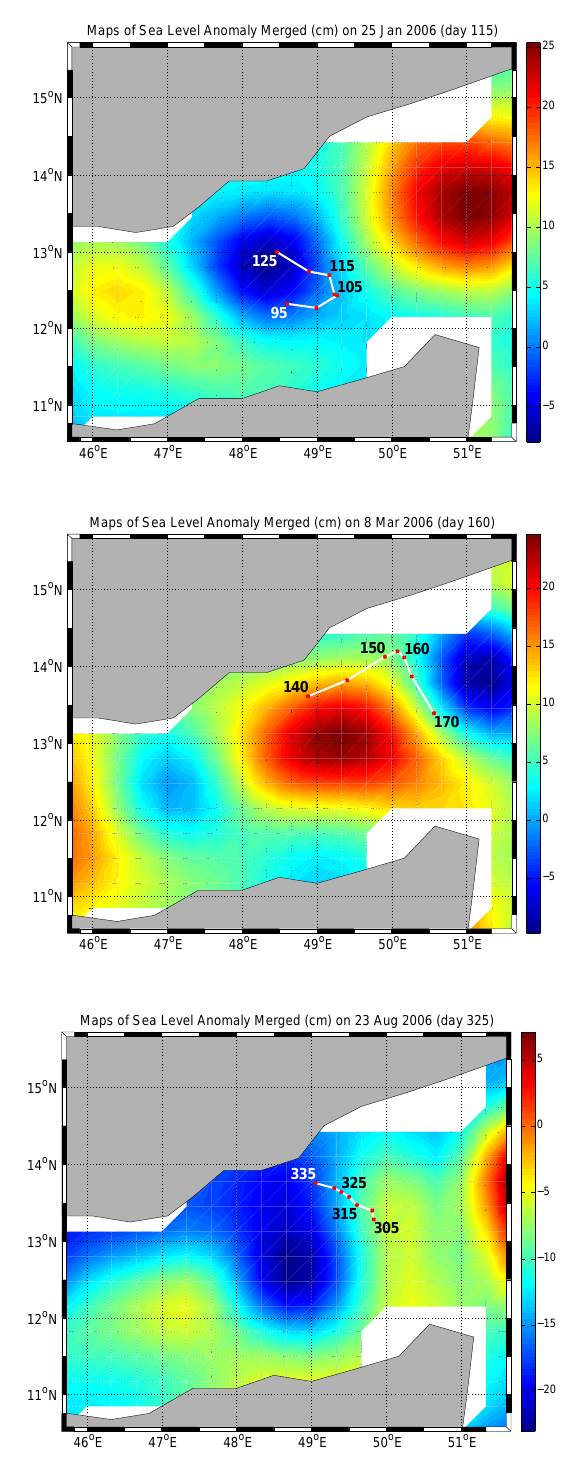
Fig. 8. From top to bottom, sea-level anomaly (SLA) maps of 25 Figure 8: Sea-level anomaly (SLA) maps of January 25th and March 8th 2006 (days 115 and 160 of the mission - from top to bottom, previous page); SLA map of August January, 8 March and 23 August 2006 (days 115, 160 and 325 of the 23th, 2006 (day 325 of the mission - this page). The trajectory of float 2900392 is mission). The trajectory of float 2900392 is superimposed. Dots superimposed. Dots indicate the position of the float every 5 days. Mission days are indicate the position of the float every 5 days. Mission days are indicated next to the dots. indicated next to the